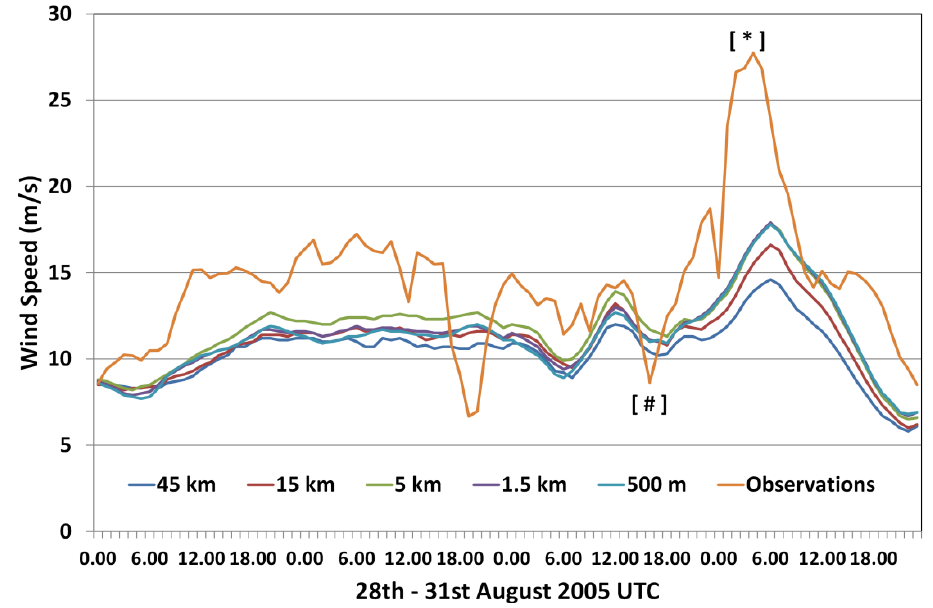
Figure 4. TAPM forecasts at all resolutions and the wind farm observations over the period 28th–31st August 2005.